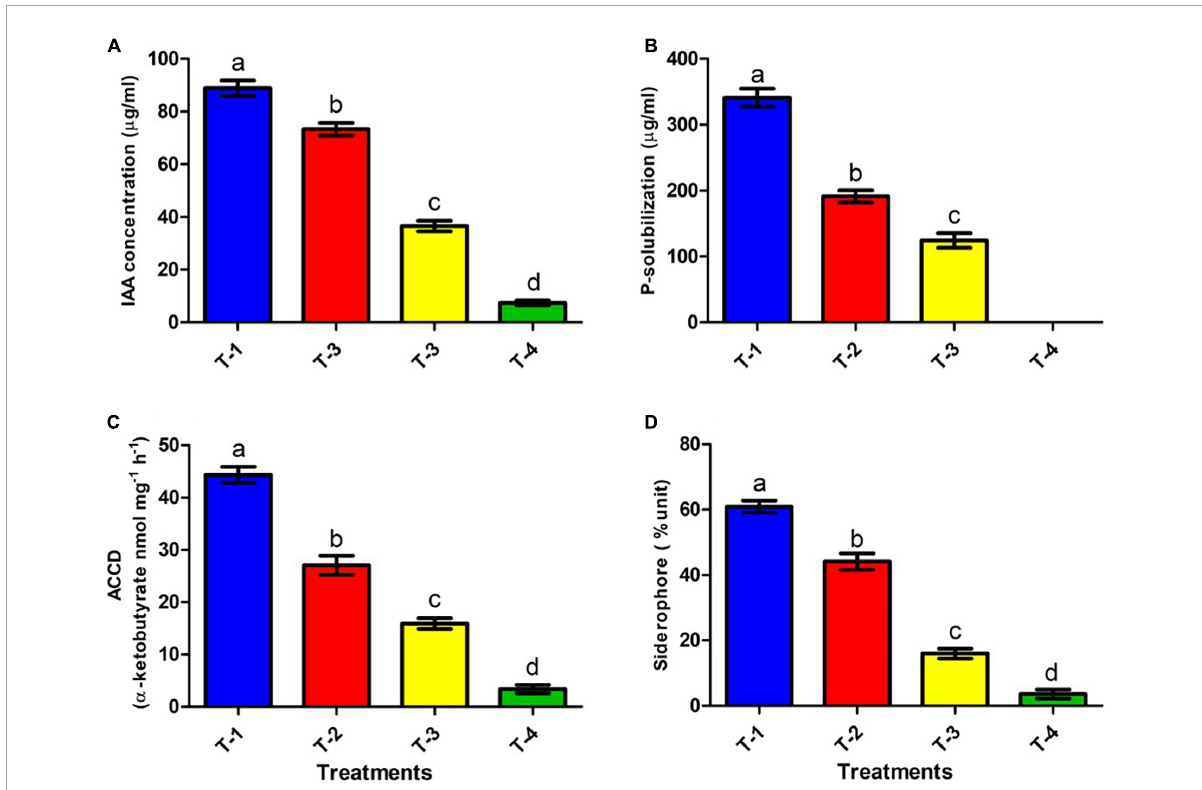
FIGURE4 Effect of CBZM stress on plant growth promoting attributes of rhizobacteria isolates ANCB-12. (T-1) No CBZM concentration, (T-2) 1,000 µ g/ml CBZM, (T-3) 2,000 µ g/ml CBZM, and (T-4) 3,000 µ g/ml CBZM. (A) IAA production, (B) phosphate solubilization, (C) ACC deaminase activity and (D) siderophore production. The data represent the mean ± SEM ( n = 3) of three replicates. The error bars display the standard error mean (SEM). Letters on each bar denote significant variances ( p ≤ 0.05) according to the DMRT